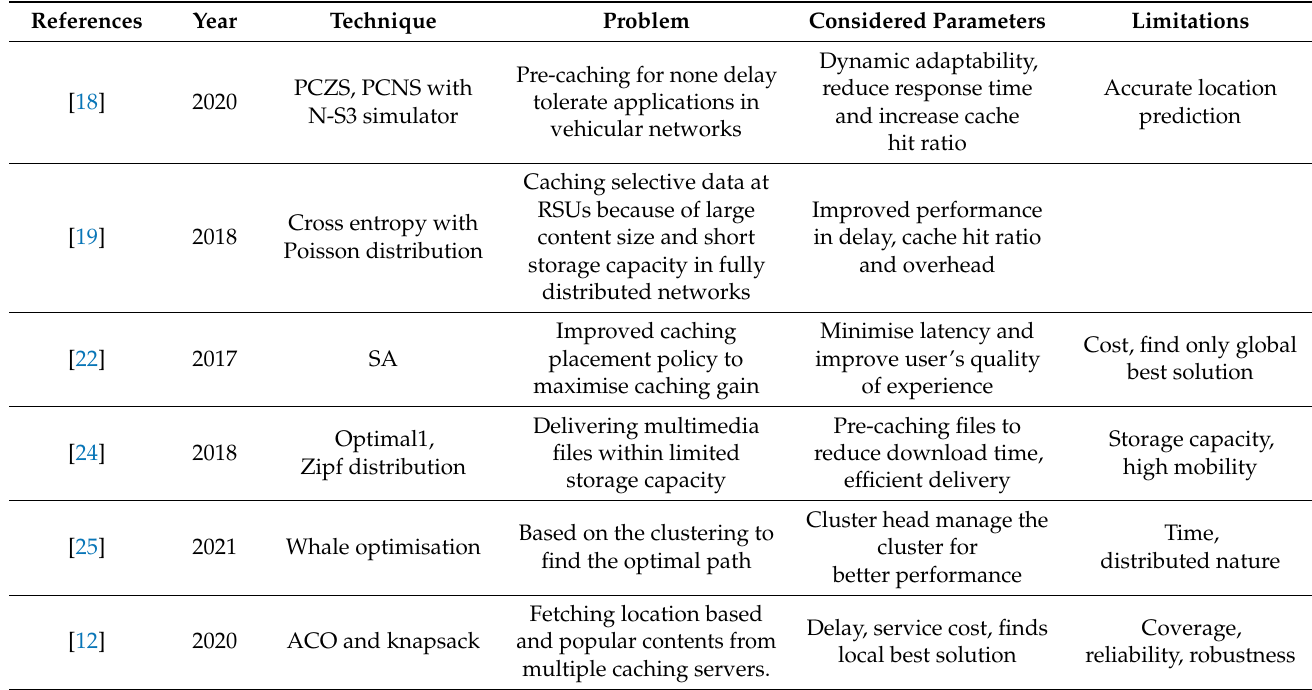
Table 1. Comparison of the related